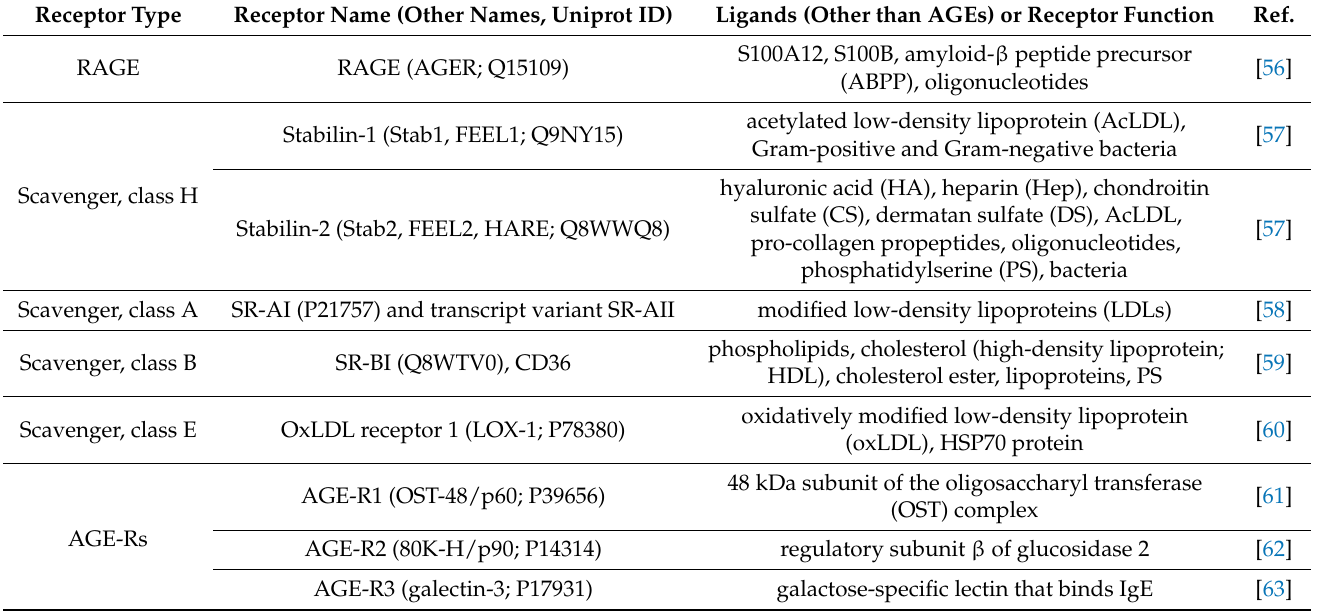
Table 3. Human cell surface receptors for